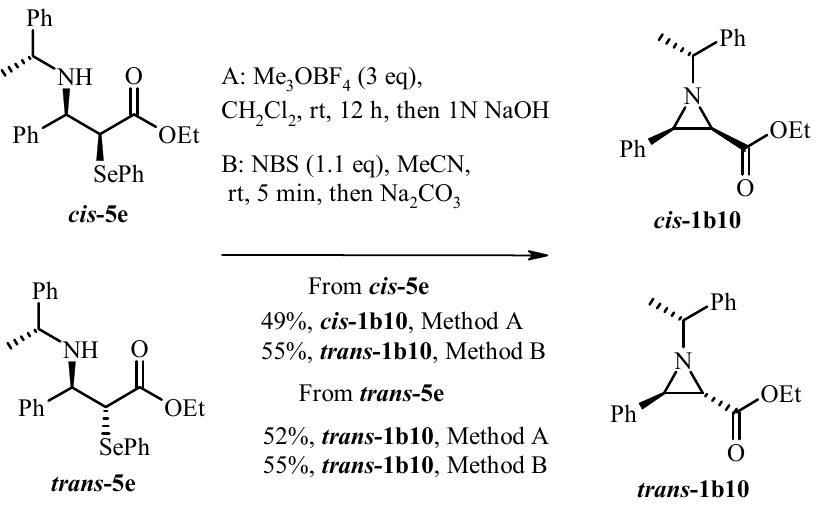
Scheme 14. Cyclization of amino selanyl esters 5e .